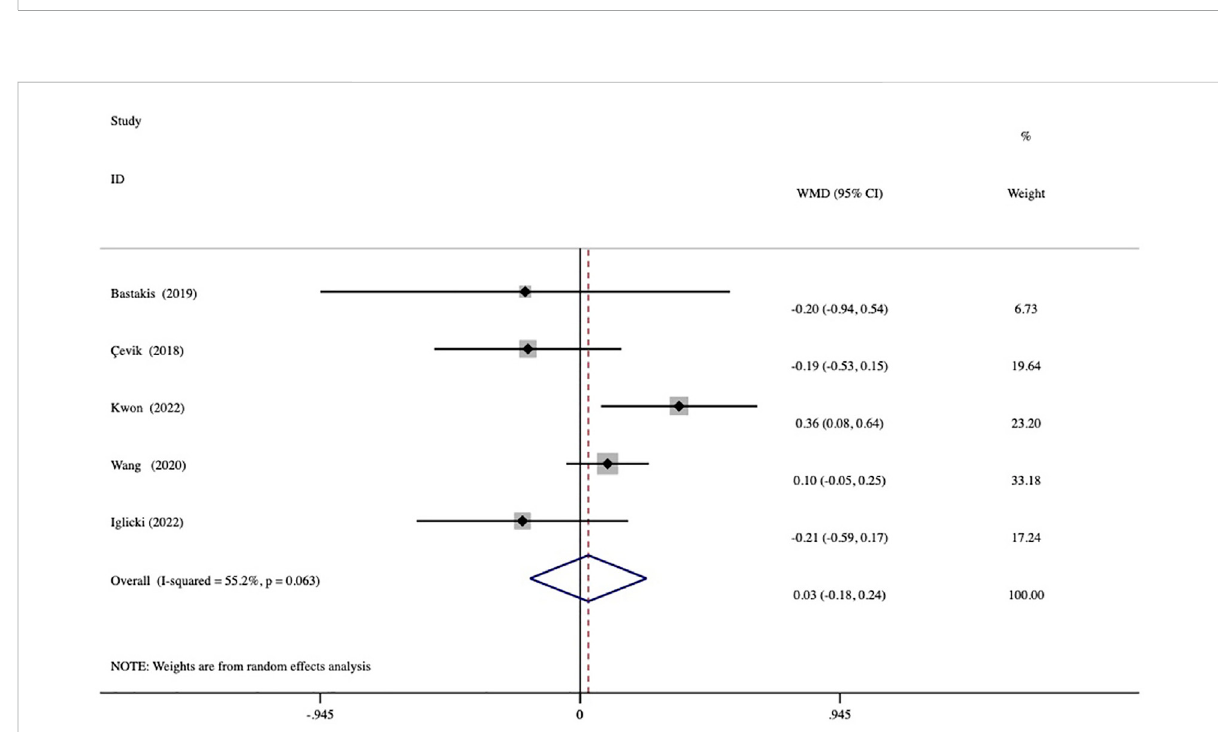
Forest plots of the comparison of the mean number of injections between the vitrectomized and nonvitrectomized groups during the follow- up